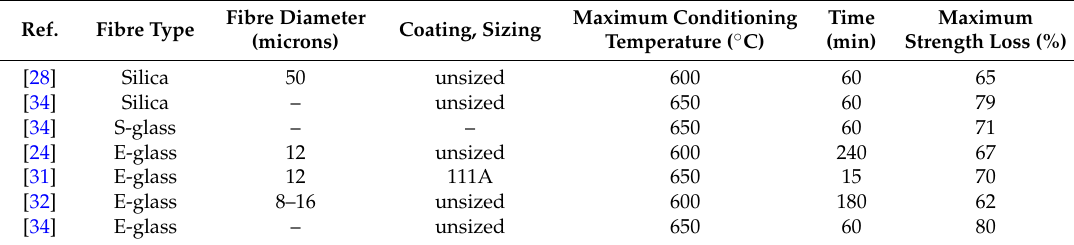
Table 1. Overview of selected results from the literature on fibre strength loss after heat conditioning.